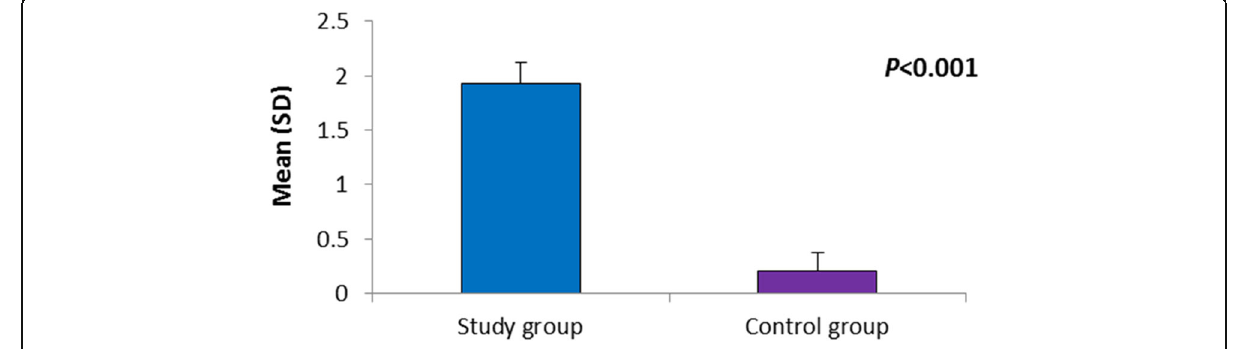
Fig. 1 Level of sHLA-G in enrolled women (ng/mL)